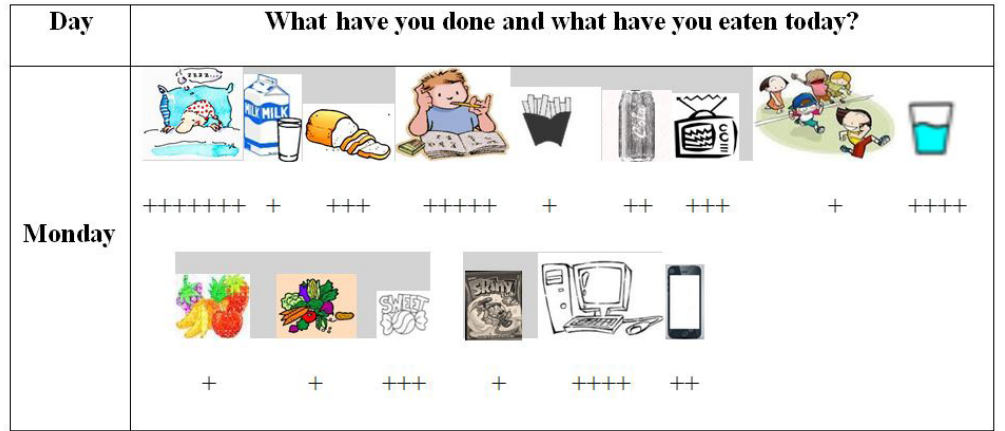
Figure 2. Example of one weekday entry by one child in his